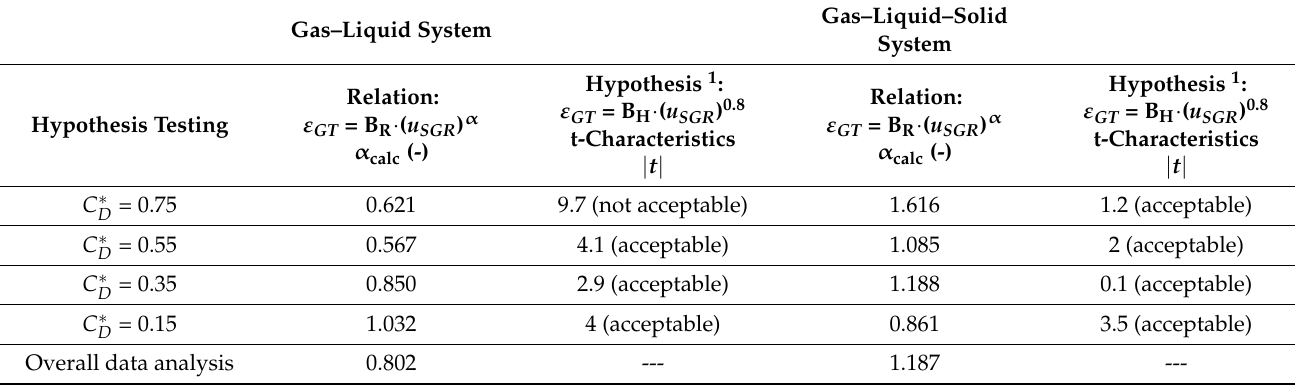
Table 7. Total gas holdup ε GT : Results of the hypothesis testing-effect of riser superficial velocity u SGR for deflector clearance C ∗ = const. D